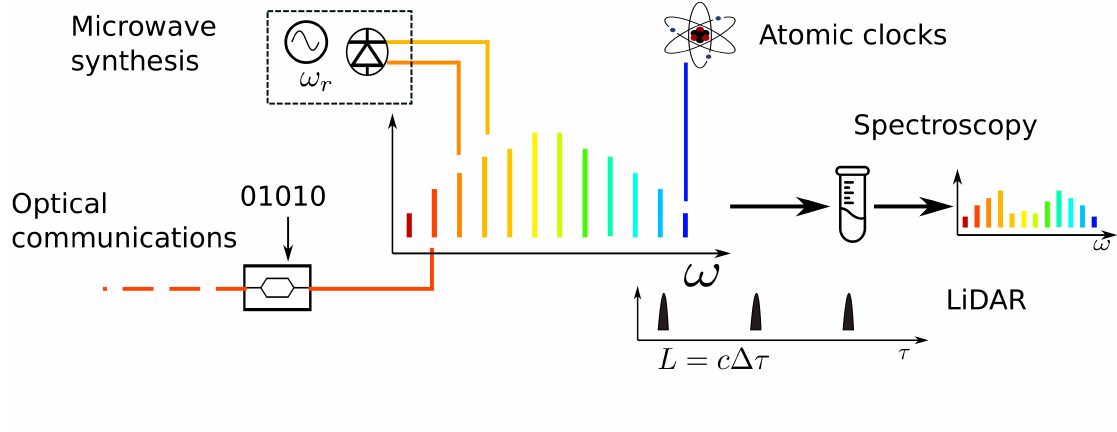
Figure 1. Frequency combs find applications in (i) low-noise microwave signal generation and processing, (ii) gears in atomic clocks that measure the precise frequency of atomic transitions, (iii) broadband light sources in spectroscopy. They can also be viewed as (iv) a source of densely spaced optical channels for optical communications and (v) source of high peak-power pulses in time-of-flight